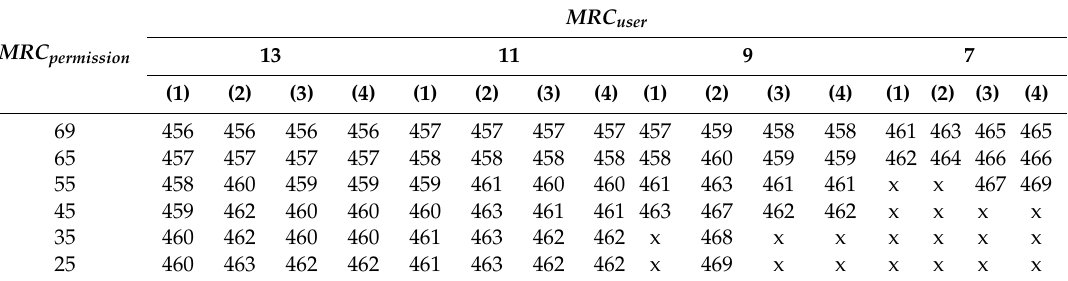
Table 20. The number of optimized roles in Apj.